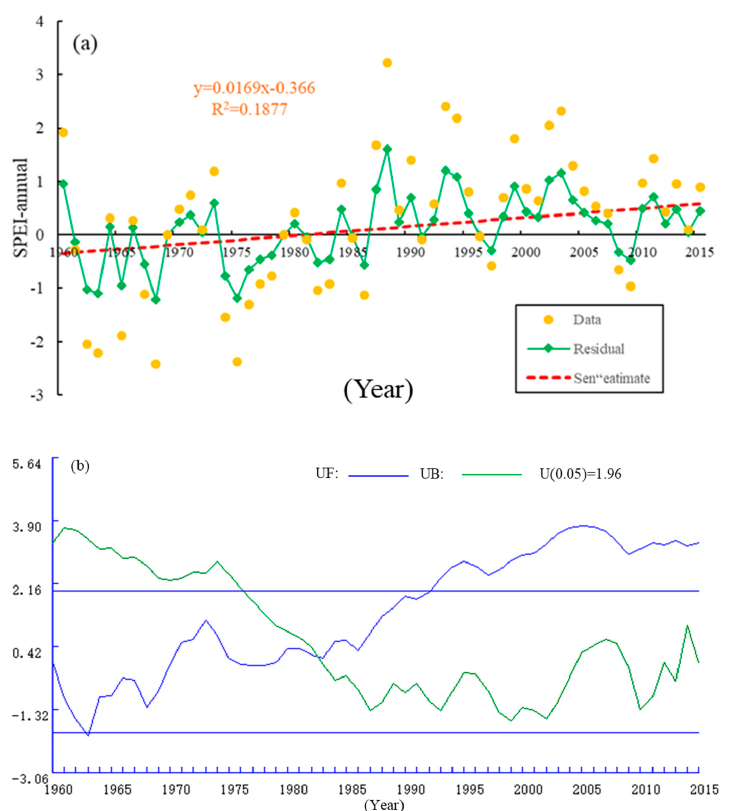
Figure 2. Interannual variation ( a ) and Mann–Kendall test ( b ) of average SPEI of NXC between 1960 and 2015. (Blue line (Green line) is UF (UB) line. Horizontal line is the level of 0.05 significance line. Land 2020 , 9 , 90